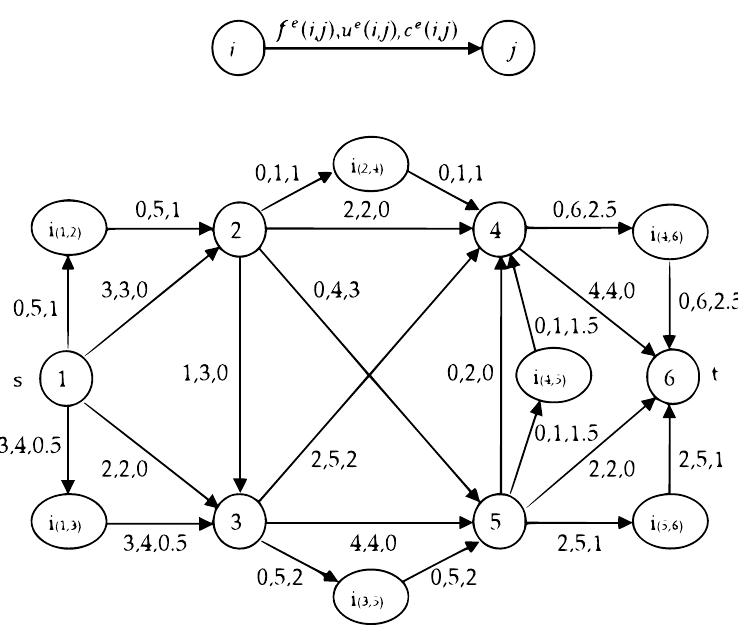
Figure 4. The network G e and the minimum cost flow f e of value w = 8.